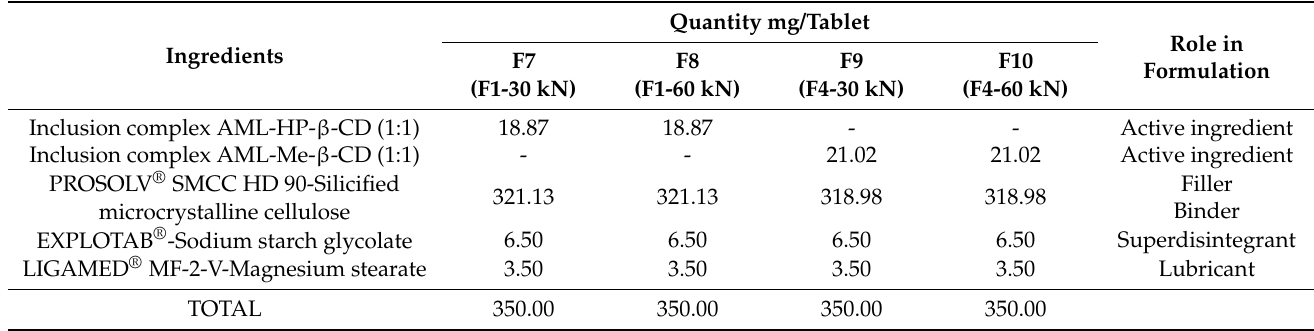
Table 2. The formulations of the orally dispersible tablets containing AML-HP- β -CD (F7 and F8) and AML-Me- β -CD (F9 and F10) inclusion